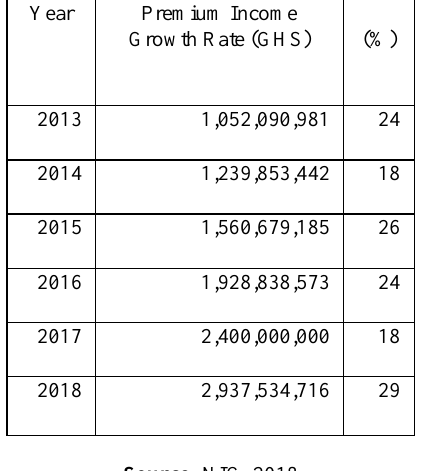
Table 1: Insurance Growth from 2013 to